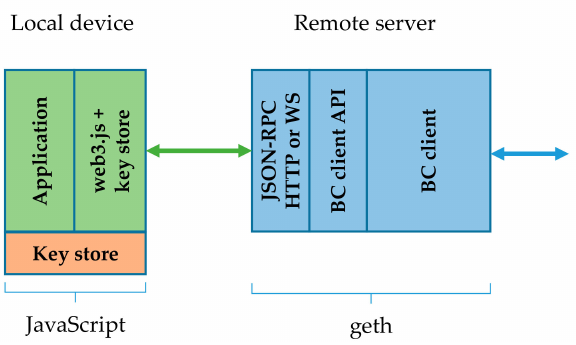
Figure 4. Remote geth client with local key